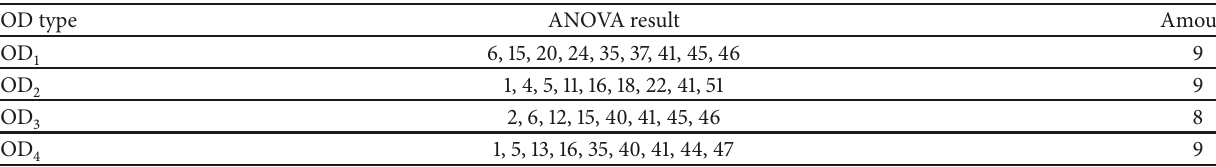
Table 2: ANOVA results for 56 road sections.